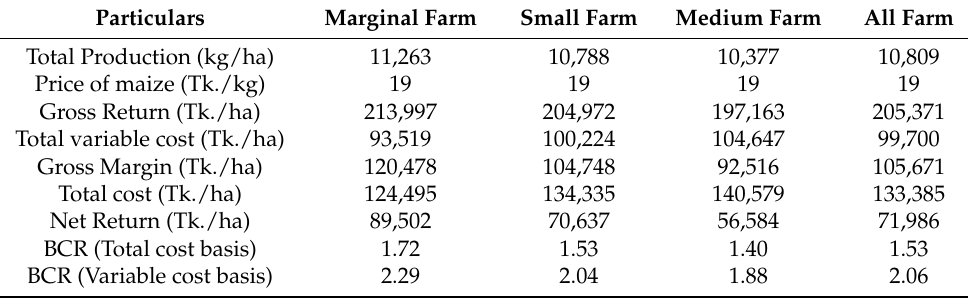
Table 4. Per hectare cost and return of maize